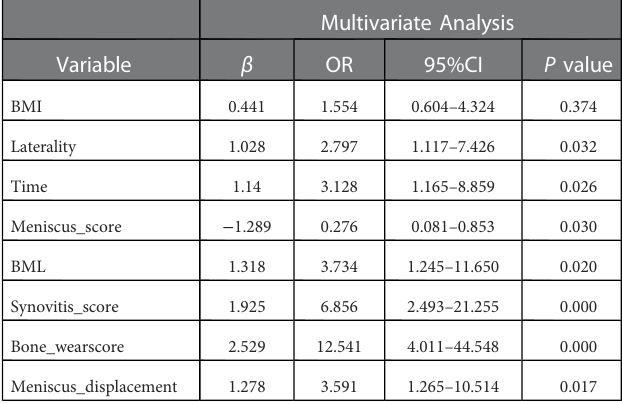
TABLE 3 Logistics regression multifactor analysis.